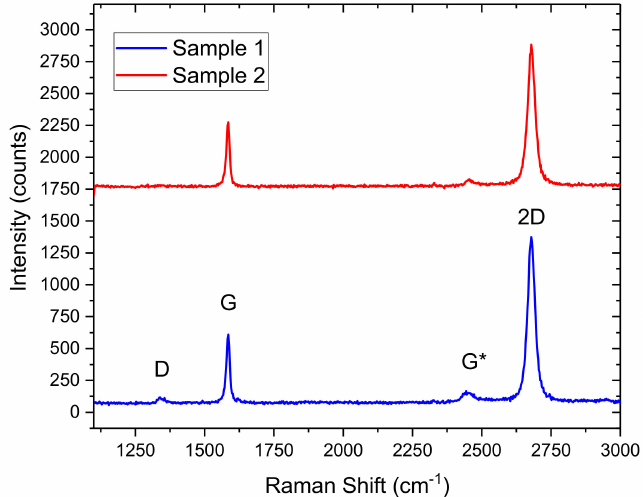
Figure 2. Raman Spectra of quality and defected chemical vapour deposition (CVD) graphene before being deployed as the transducer element in a graphene field effect transistor (GFET) biosensor. The defected sample (blue) shows a prominent